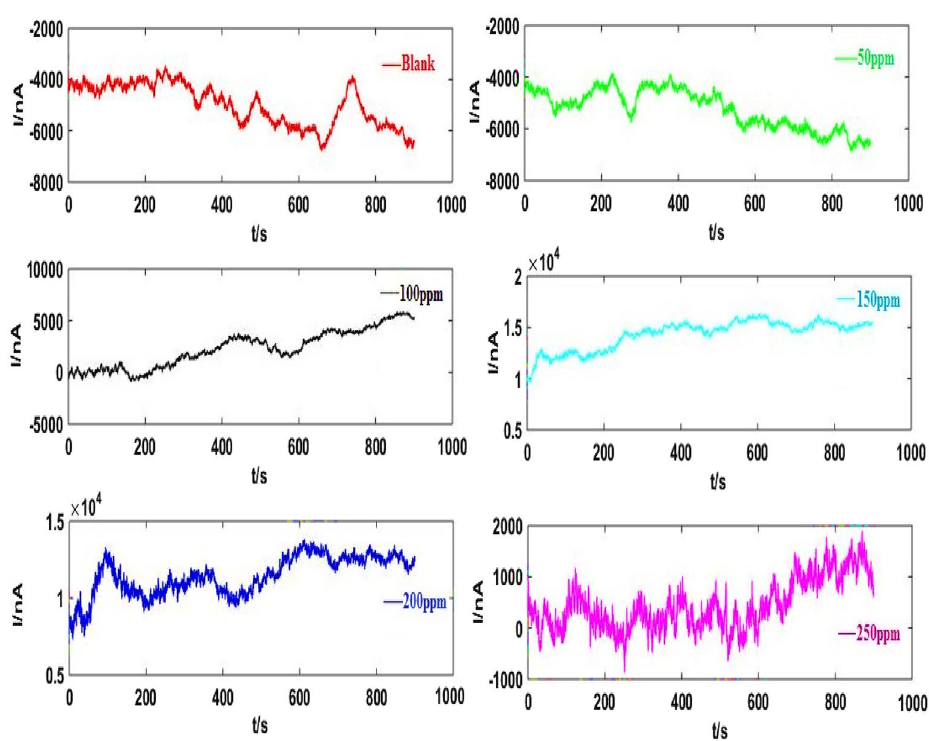
Figure 7. EN current records before elimination trend of Sy-Co in absent and presence of varies concentrations of RA/Ag